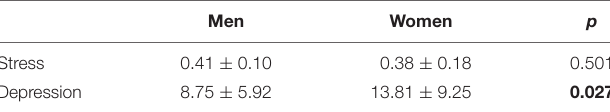
TABLE 2 | Depression and stress